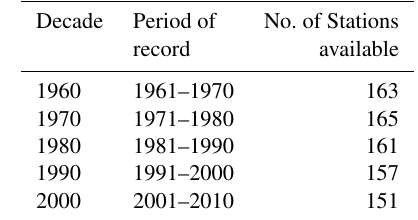
Table 1. Decadal